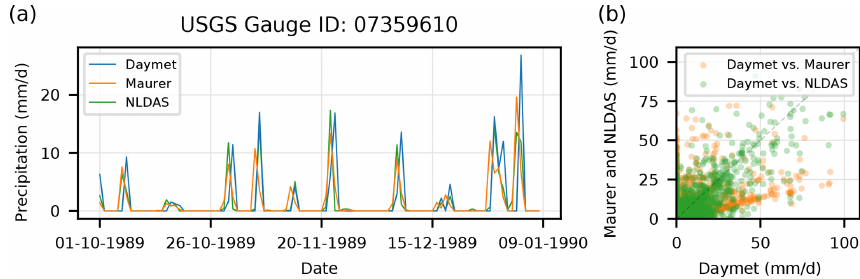
Figure 1. Illustration of the relationship between three CAMELS precipitation products at a randomly selected basin (USGS ID 07359610). Panel (a) shows the first 100d of precipitation data from all three products during the test period, and panel (b) shows scatter between the three products over the full test period. The scatter shown in (b) is the data uncertainty that we would like to mitigate. In this particular basin, there appears to be a 1d shift between Daymet and Maurer, which is common in the CAMELS data set (this shift is apparent in 325 of the 531 basins; see Fig. 2).